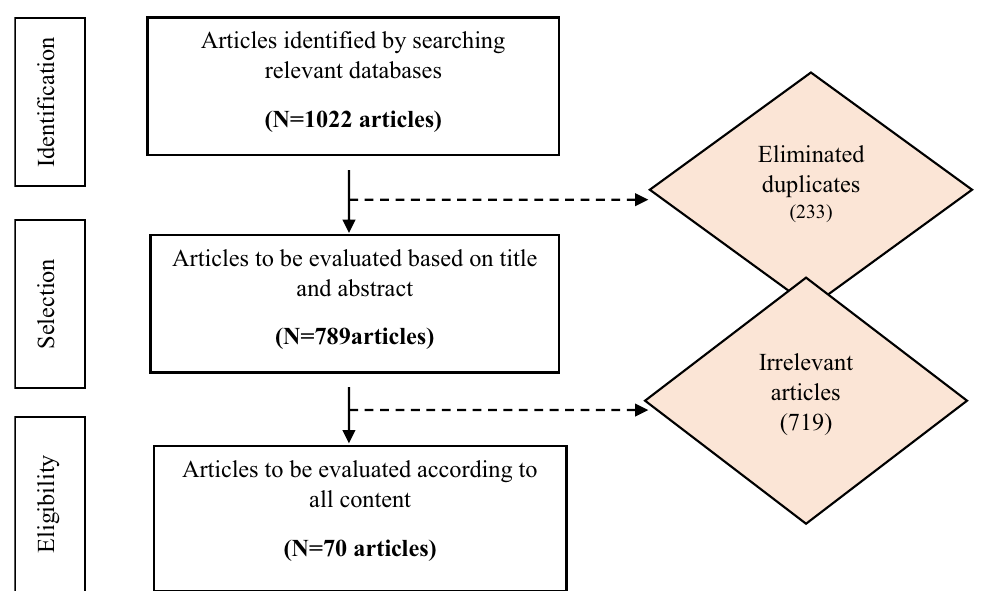
Fig. 1 Selection and evaluation of reviewed